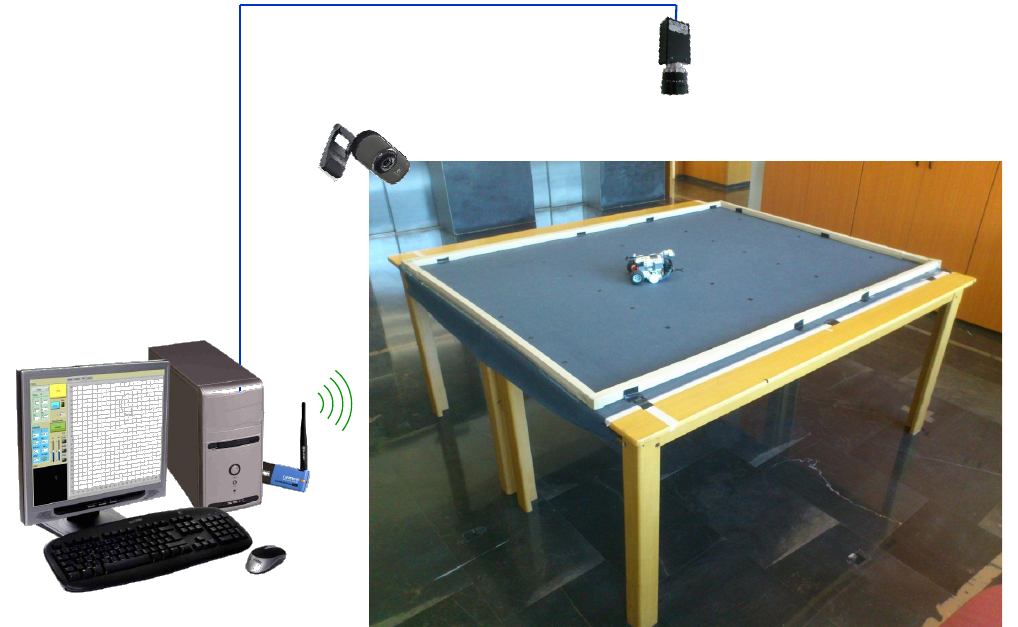
Figure 2. Server side of the